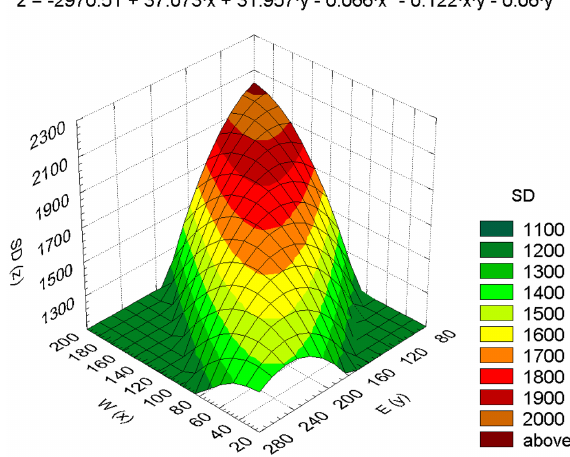
Fig. 9. Relationship between the annual SD (unit: hours) in Poznań and the annual frequency of macrotypes W and E of the mid-tropospheric circulation (unit: number of days per year) in 1959–2020. SD, sunshine duration.